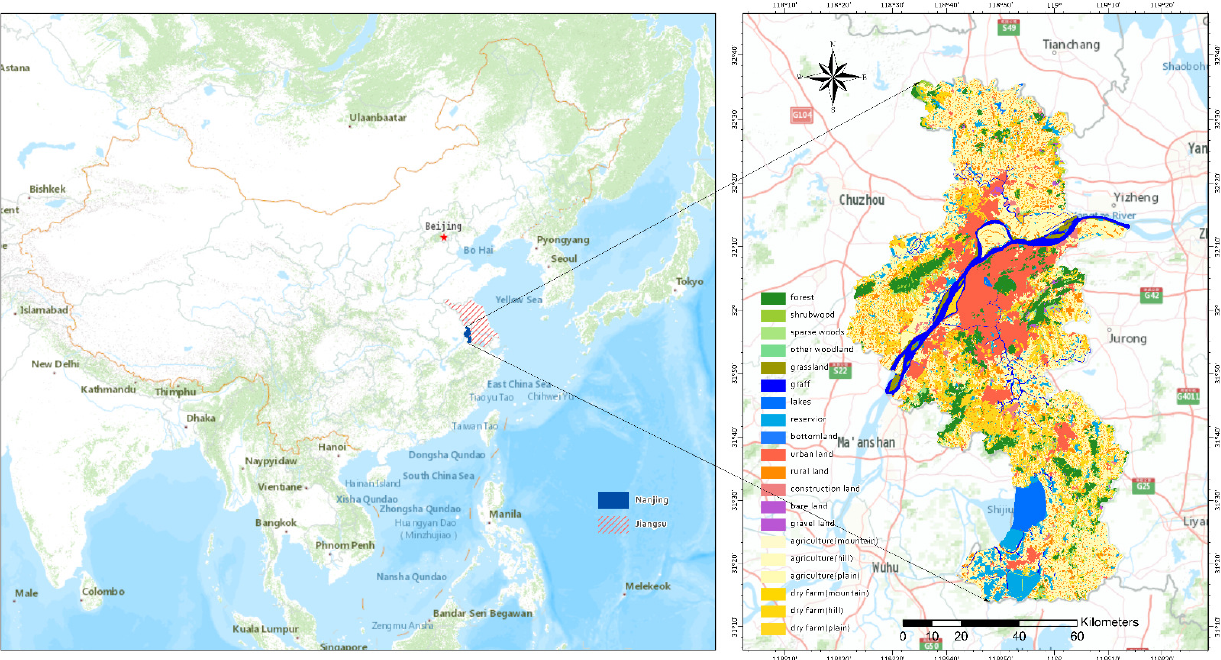
Figure 2. Location and map of Nanjing